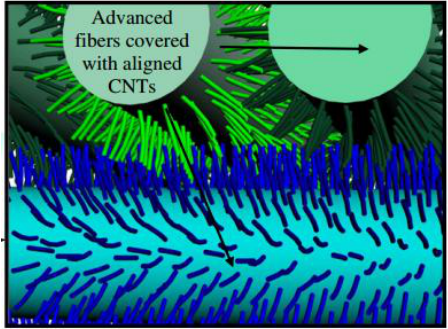
Figure 23. CNT/Alumina hybrid composite: internal nanoscale interaction between alumina fibres and carbon nanotubes, with permission from 154.